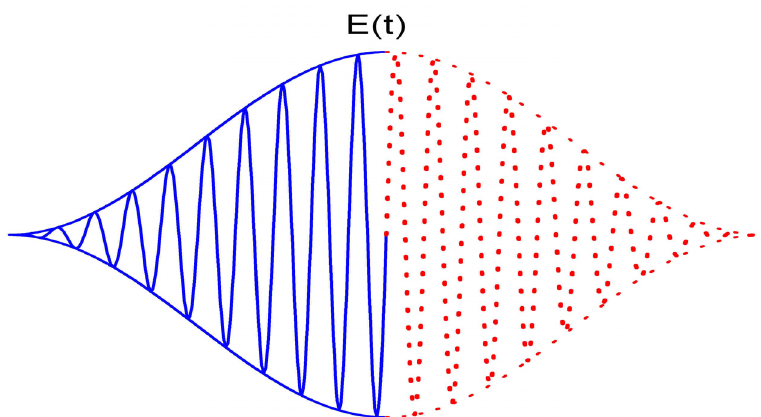
Figure 1 . Illustration of the positive (solid line) and negative (dotted line) chirp of High-order harmonic generation (HHG) by the rapid change of the electric field E ( t ) (Equation (5)). The total pulse duration τ is 20 optical